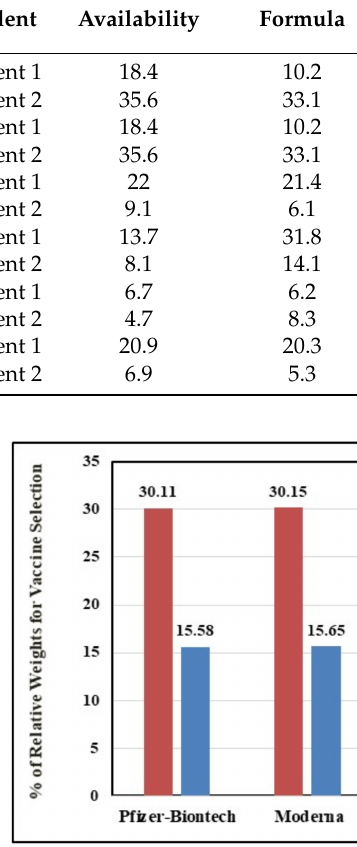
Figure 1. Percentage of Relative Weights for Vaccine